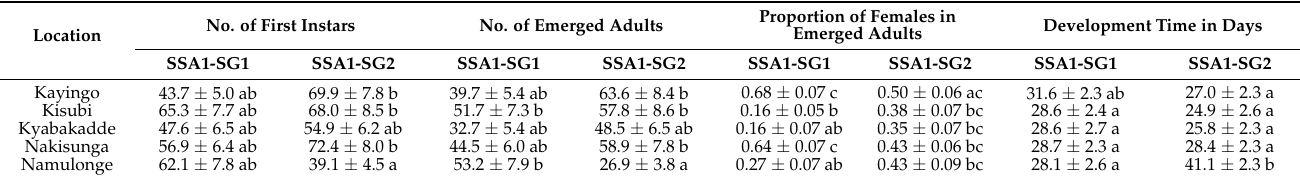
Table 3. Development differences (number of first instars, emerged adults, proportion of females in emerged adults and development time) among SSA1-SG1 and SSA1-SG2 genotypes collected from five different locations (Kayingo, Kisubi, Kyabakadde, Nakisunga and Namulonge) in the insectary (Natural Resources Institute, UK).